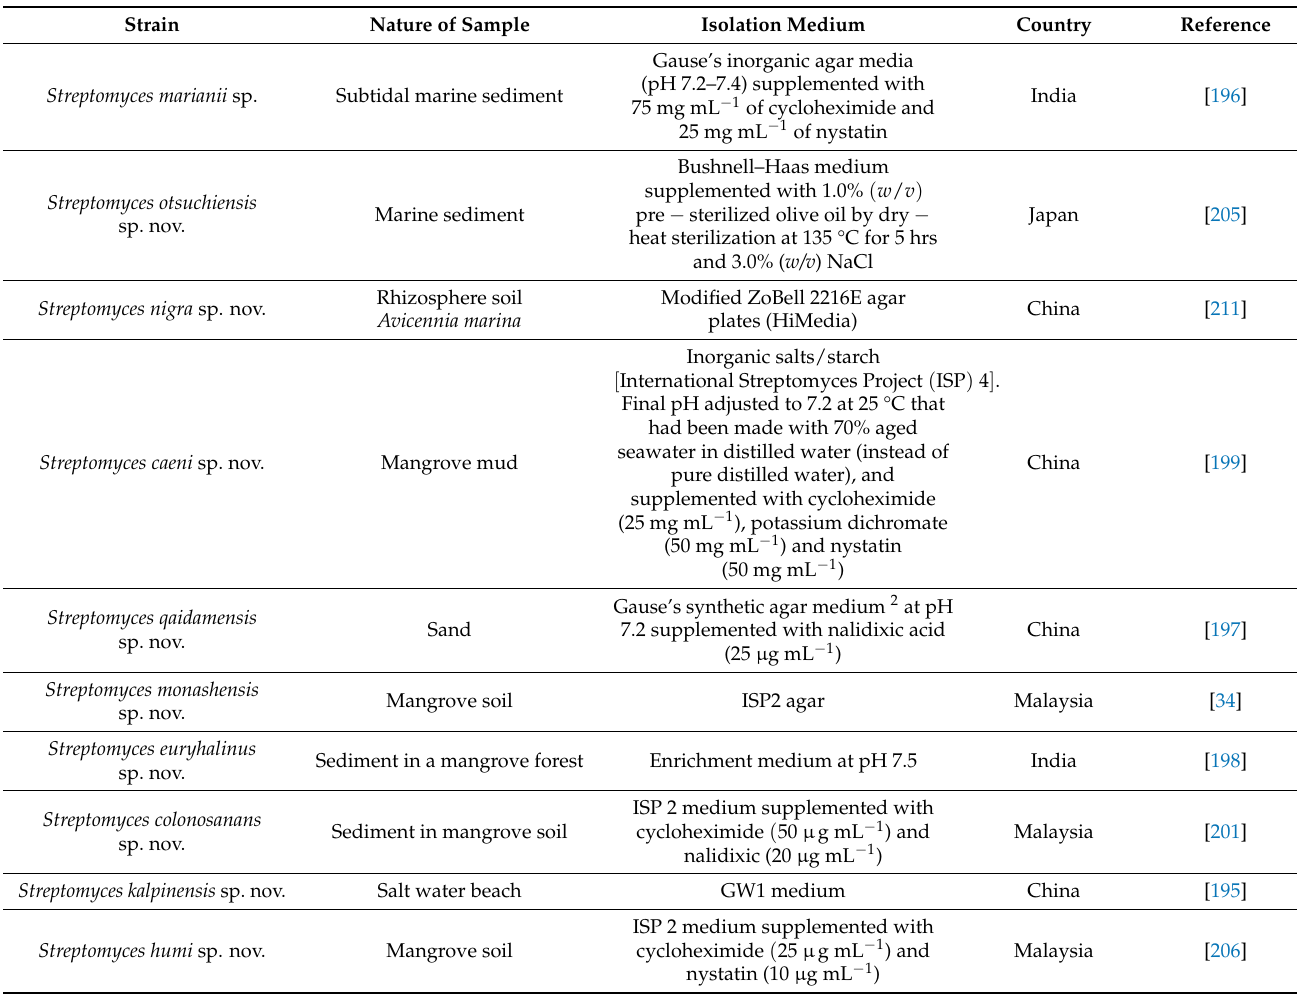
Table 7. Novel Streptomyces spp. from marine sediments between 2015 and